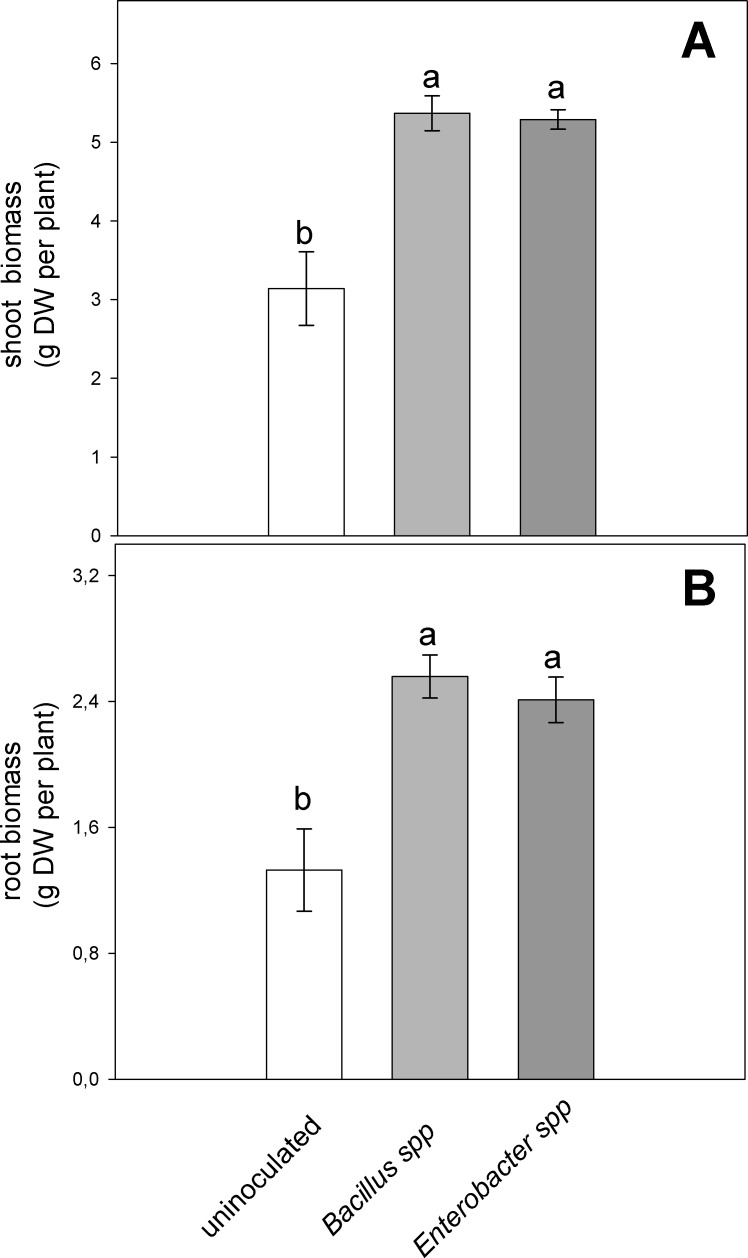
Effect of severe water stress (FSTW10) on shoot (A) and root (B) biomass of velvet bean plants grown in soil inoculated with Enterobacter spp. and Bacillus spp., or uninoculated. Values are mean of five plants ± SE, letters indicate significant differences among treatments (P < 0.05).